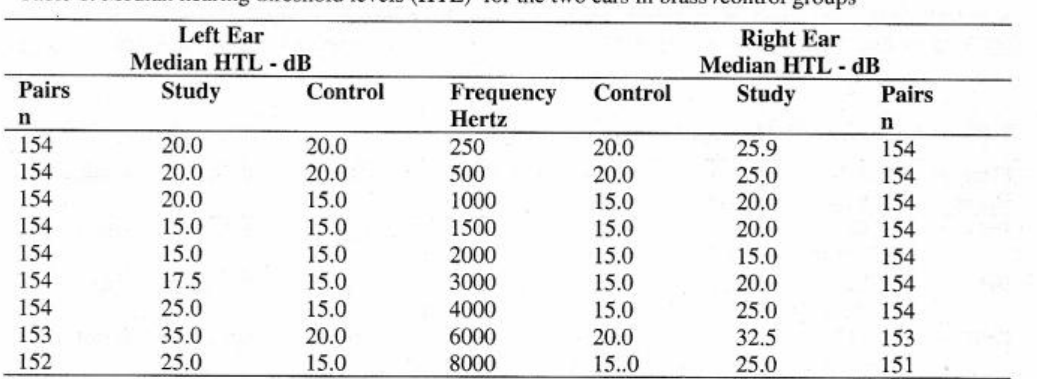
Table 1: Medianhearing threshold levels (HTL) for the two ears in brass /control groups